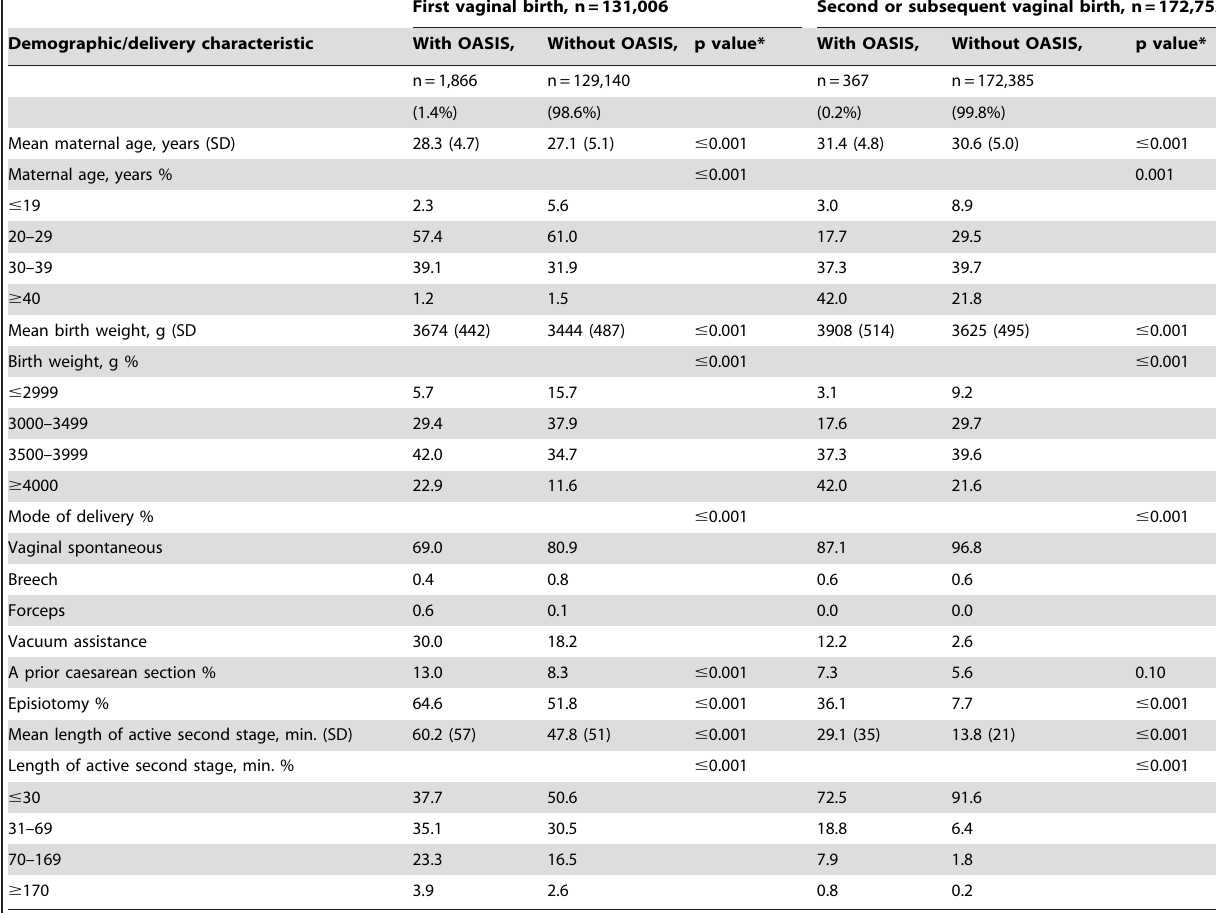
Table 1. Demographics and delivery characteristics separately among women with first vaginal singleton births including women with first vaginal birth after a prior caesarean section and second or subsequent vaginal births with and without OASIS from 2004– 2011 in